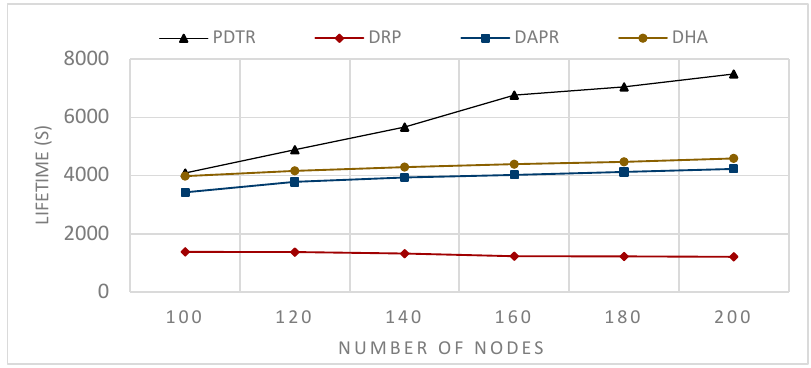
Figure 11. Impact of varying the number of nodes on the network lifetime.